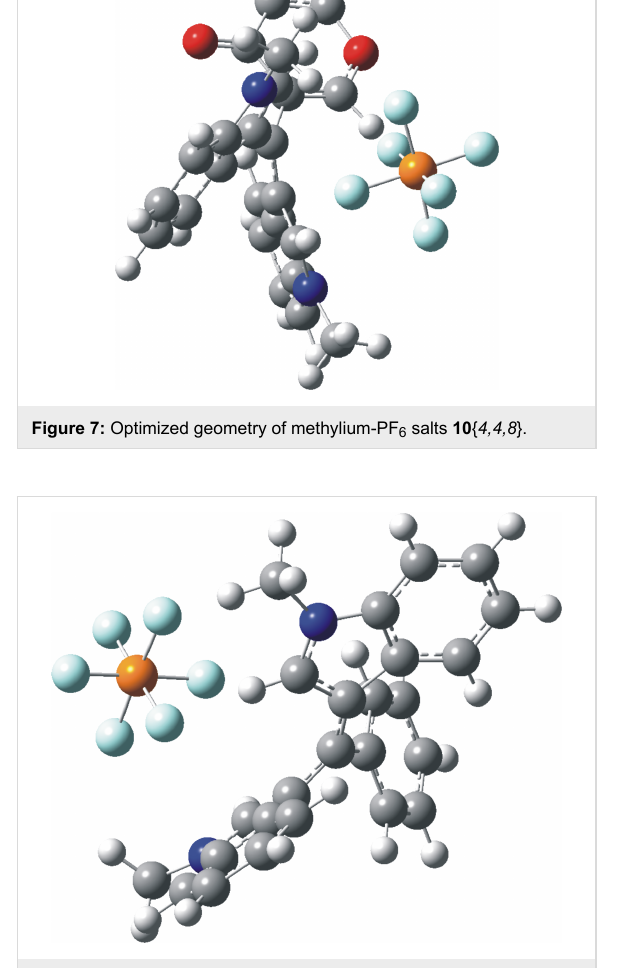
Figure 8: Optimized geometry of methylium-PF 6 salt 10 { 4,4,11 }.